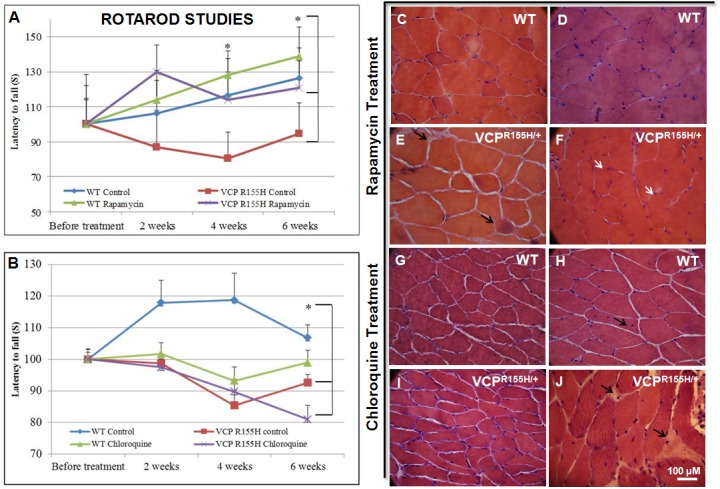
Rotarod performance and histological analyses of quadriceps in WT and VCPR155H/+ mice treated with rapamycin or chloroquine.Rotarod analysis of (A) rapamycin-treated and (B) chloroquine-treated 20-month old VCPR155H/+ and WT versus control animals at 2 week intervals. Histological analysis by H&E staining of quadriceps pathology from 20-month old control and (C-F) rapamycin- and (G-J) chloroquine-treated VCPR155H/+ and WT mice. White arrows point to overall improvement in the number of centrally located nuclei, reduced vacuoles, and an amelioration in the quadriceps fiber size and architecture. Black arrows point to worsened muscle pathology with increased vacuoles, interstitial space, and angulated fibers. The number of mice analyzed per experiment is 6–8.